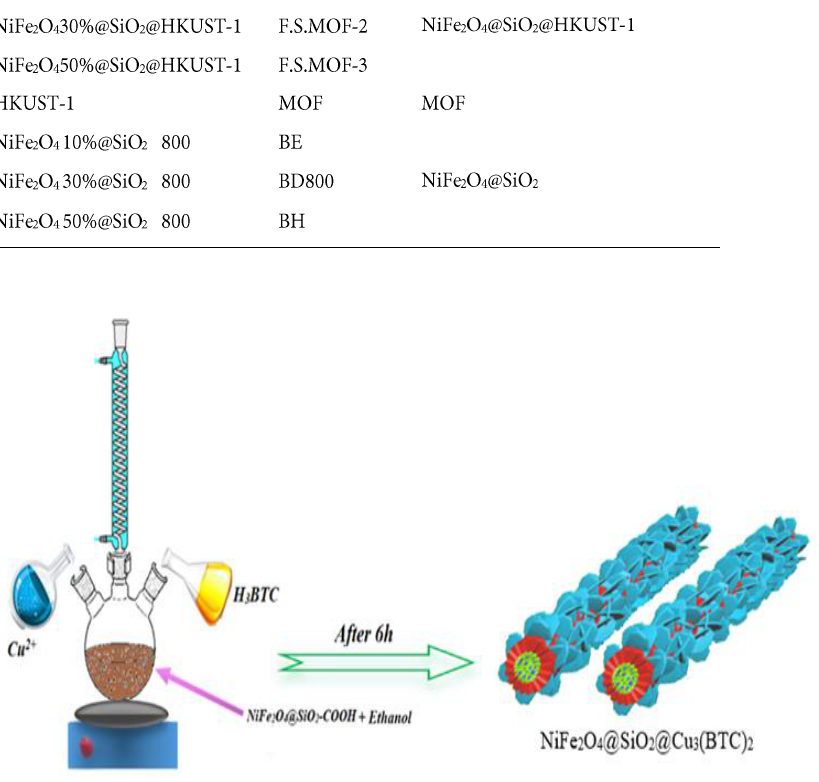
Fig. 3. Schematic of synthesis of magnetic metal-organic framework nanocomposites Fig 3: Schematic of Synthesis of magnetic metal-organic framework nanocomposites NiFe 2 O 4 @SiO 2 @HKUST- 1